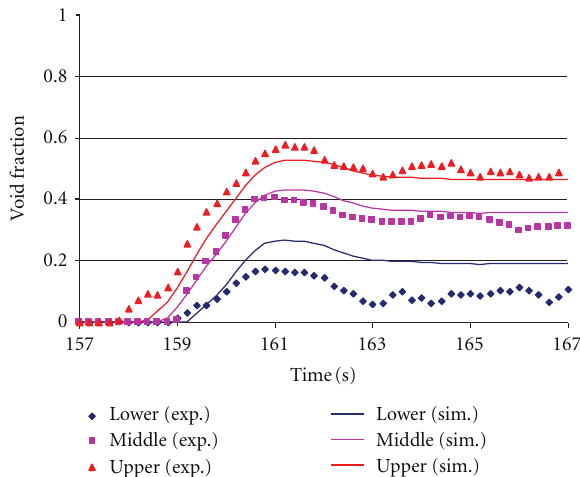
Figure 14: Void fraction comparison for flow reduction transient.